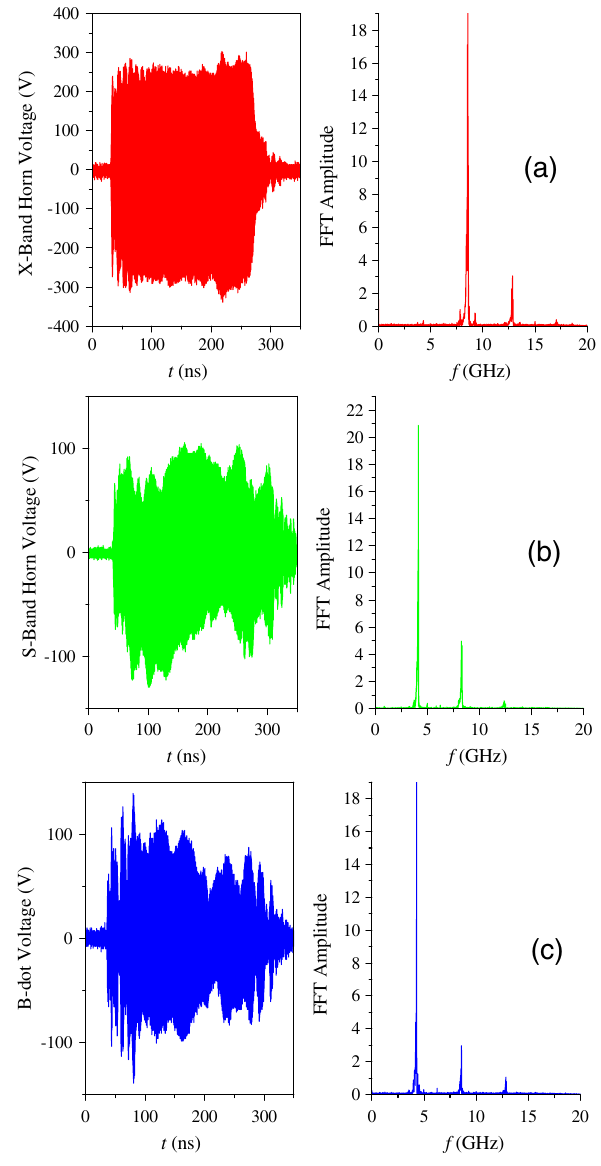
FIG. 2. (Color) Time signals and their FFTs: (a) X-band horn; (b) S-band horn for evanescent wave; (c) magnetic field (parallel to groove) at a groove